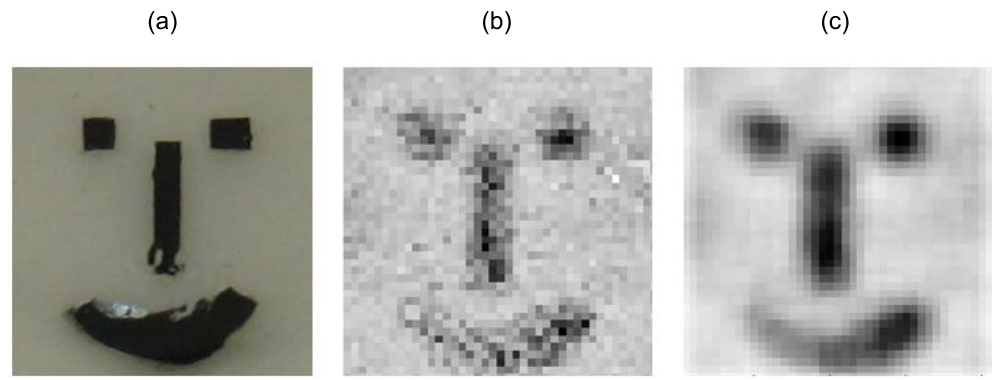
Figure 28. ( a ) Photograph of the measured object, back view; ( b ) wavelet filtered data at a time of 1.5 (cid:22)s ; ( c ) synthetic aperture focusing technique (SAFT) reconstruction of the data. The image quality is clearly enhanced (reproduced from [69] with